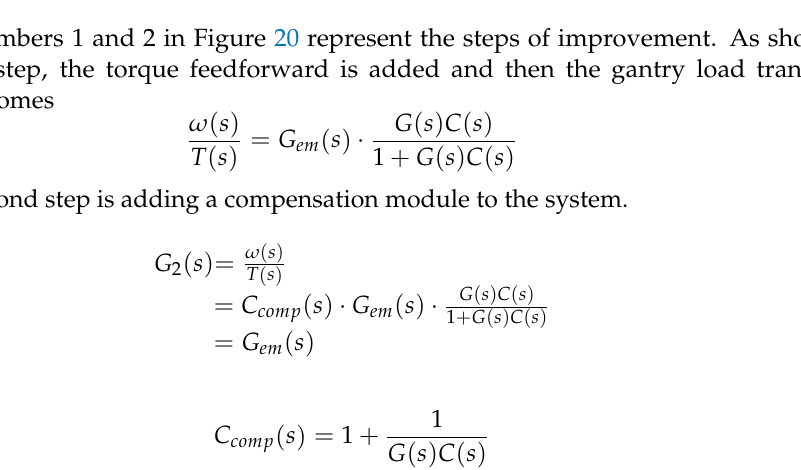
Figure 20. Forward speed tracking algorithm with feedforward and compensation.